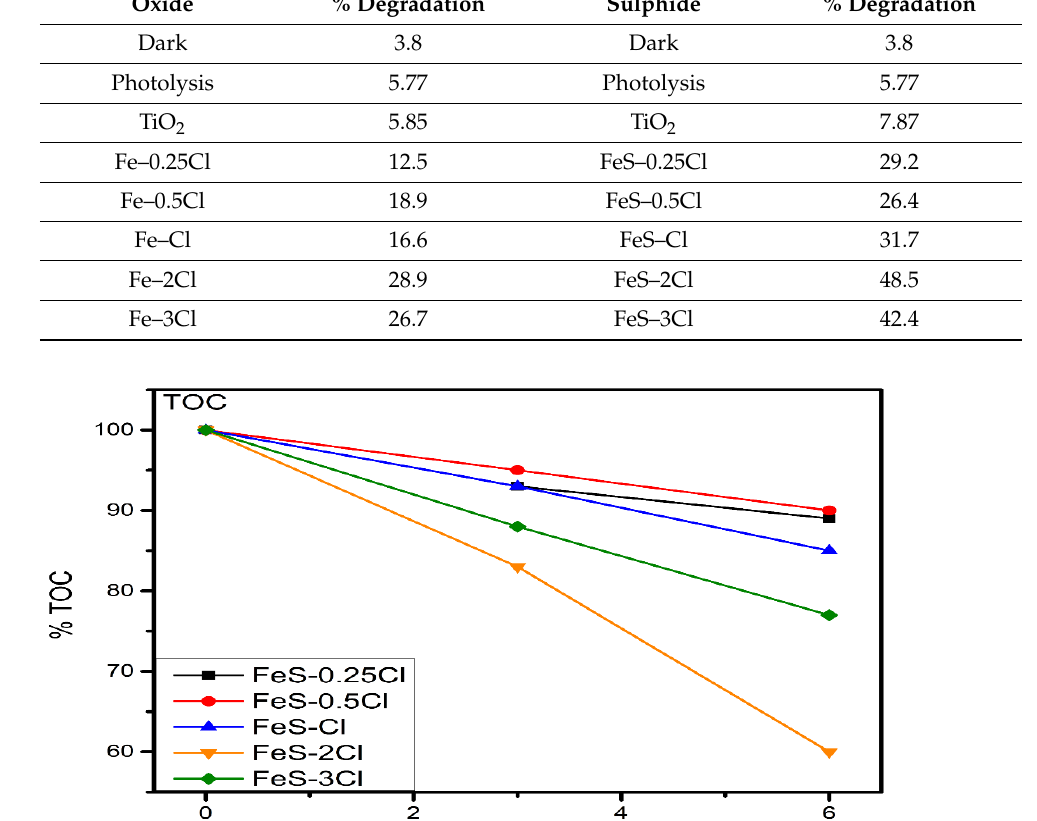
Figure 14. TOC results for FeS–0.25Cl, FeS–0.5Cl, FeS–2Cl and FeS–3Cl catalysts in visible-light region.